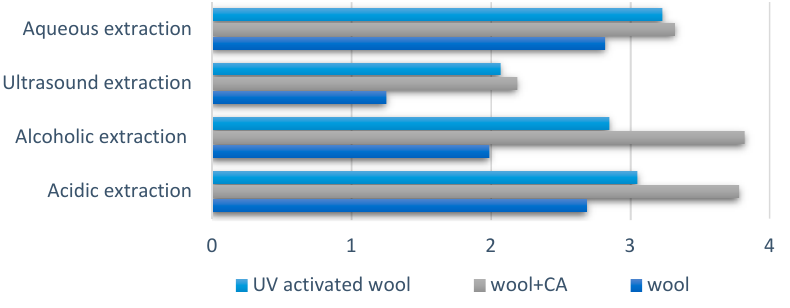
Figure 11. Color strength at 400 nm (maximum absorption). The lowest values of color strength are those of the sample dyed by sonication. This indicates that the color yield of the sample batch-dyed by sonication was lower, with lower dye absorption in the